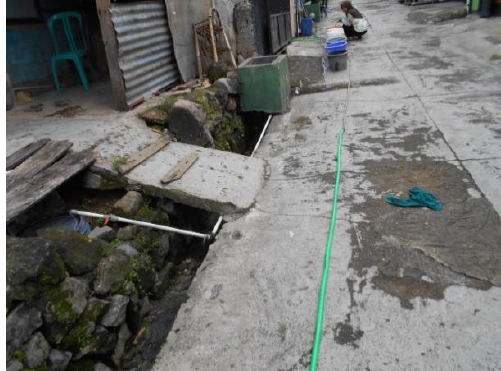
Figure 3. Household drainage.